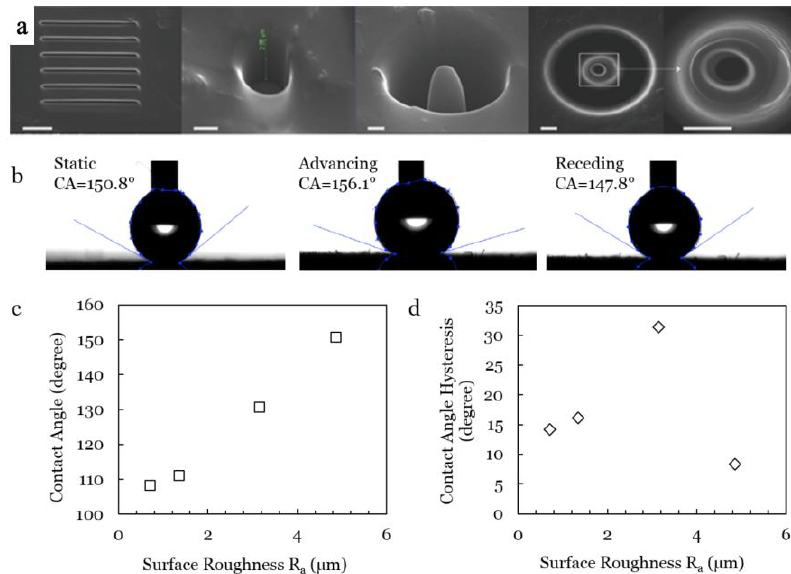
Figure 5. ( a ) FIB engineered nanostructures, from left to right, lines pattern, nano-hole, nano-probe, nano-tunnel; the scale bar is 500 nm. Static contact angle (CA) and contact angle hysteresis (CAH = advancing CA - receding CA) characterization on patterned CNP / PS polymer with FOTS layer. ( b ) CA and CAH values of a DI water droplet on superhydrophobic surface (Ra = 4.8 µ m). Relationships between ( c ) CA and surface roughness, and ( d ) CAH and surface roughness.